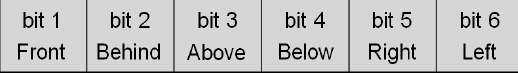
Figure 10. Cohen–Sutherland 3D six-bit representation.